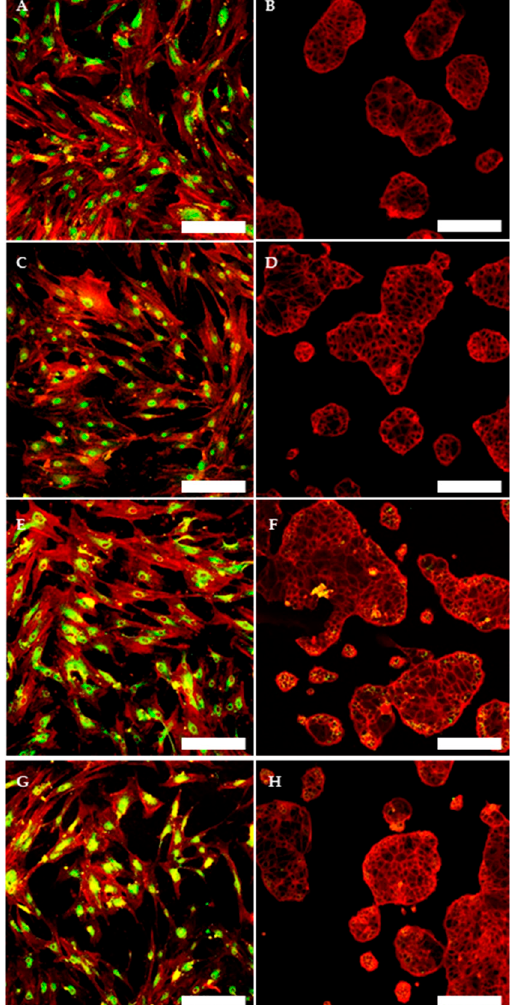
Figure 8. Immunofluorescence staining of embryonic stem cell (ESC) markers. Immunofluores- cence staining of Nanog ( A ), of KLF4 ( C ), of Sox2 ( E ) and of POU5F1 ( G ) of TOS1-CSCs line and of HCT8 cell line ( B , D , F , H ) (negative control). LSCM in conventional colors: green for ESC nu- clear/perinuclear markers and red for cytoskeleton. Original magnification: 10×.